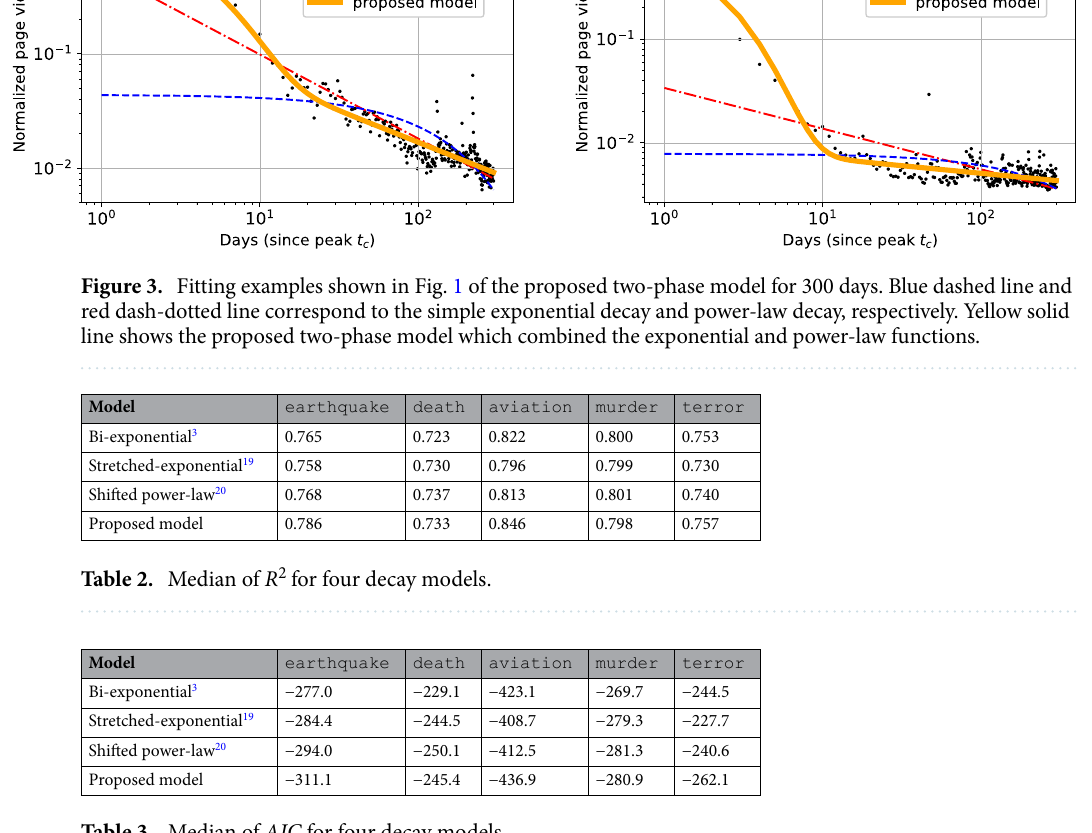
Table 3. Median of AIC for four decay